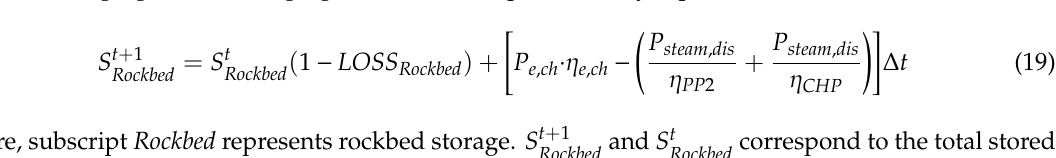
Table 4. Parameters for Rockbed